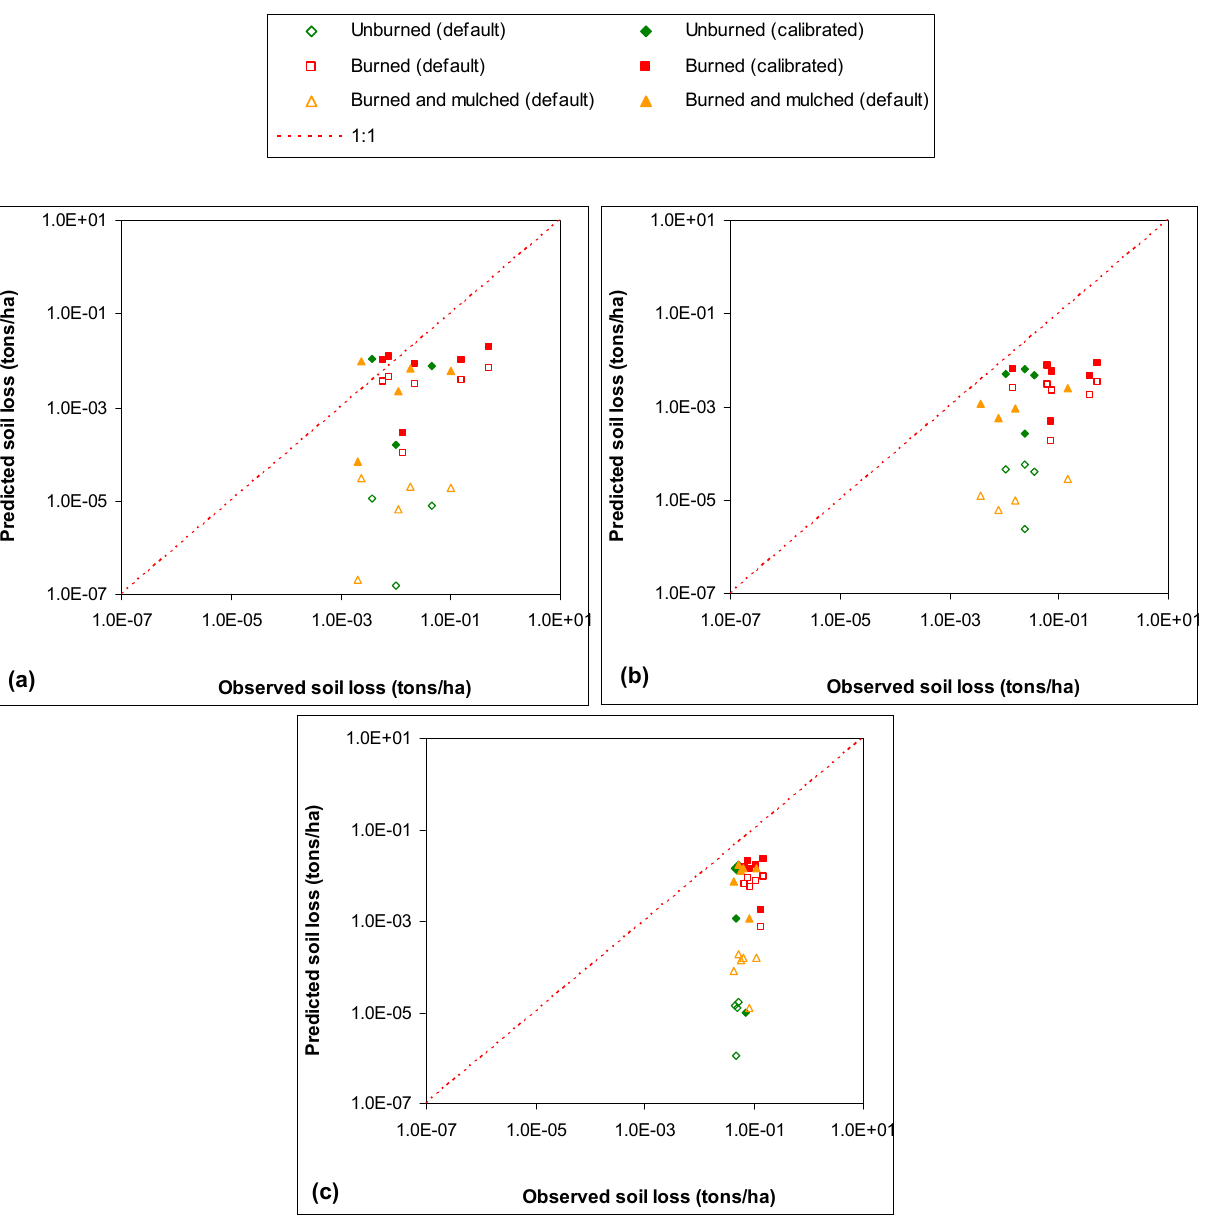
Figure 7. Scatter plots of soil losses observed in forest sites (( a ), pine; ( b ), chestnut; ( c ), oak) subject to prescribed fire and soil mulching with fern vs. predicted using the MUSLE model. Values are reported on logarithmic scales.